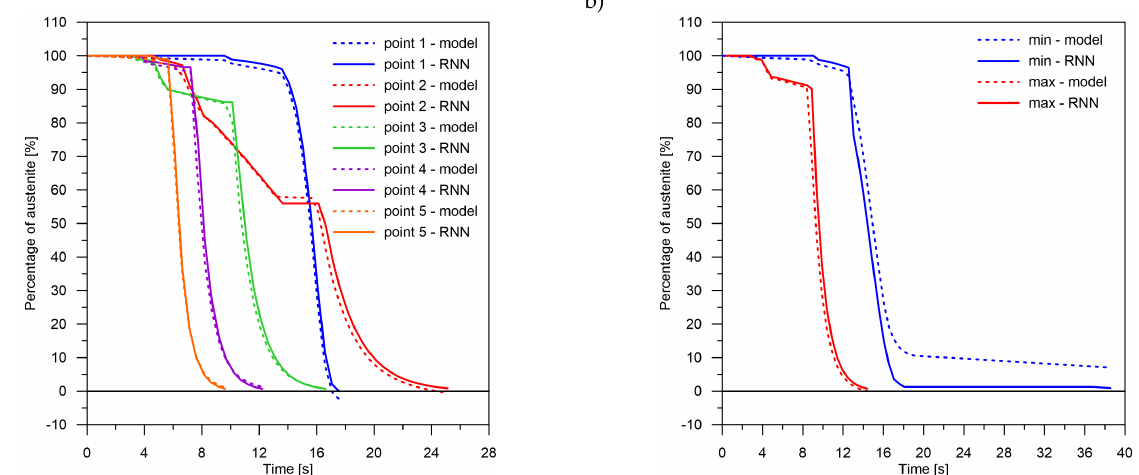
Figure 11. Kinetics of transformations: a comparison of the analytical model with the RNN model for case No.